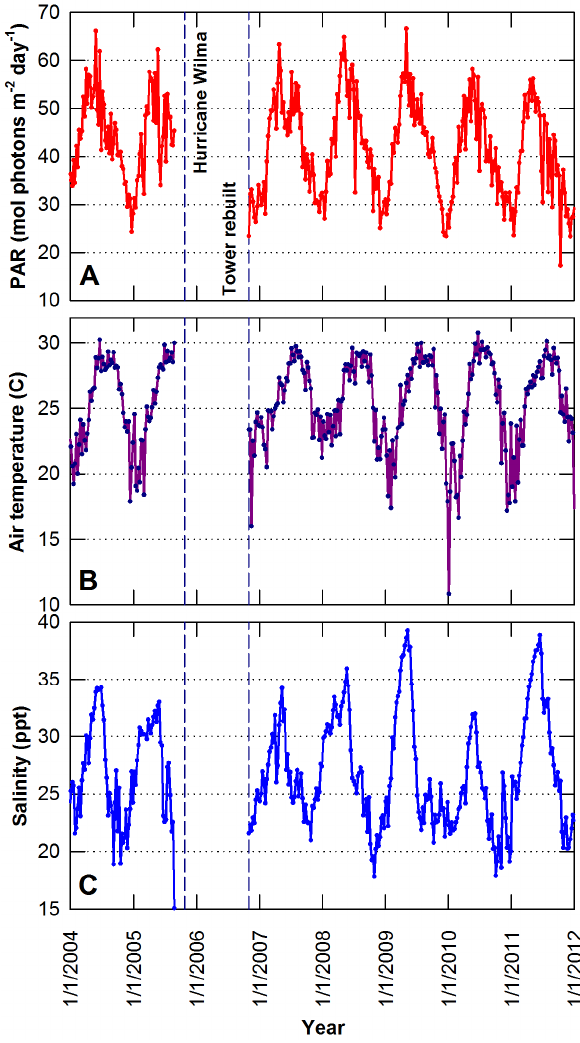
Fig. 5. Eight-day sums of –NEE, mol C m -2 day -1 ( A ) from the SRS6 tower site and derived products including ecosystem respiration, R E ; mol C m -2 day -1 ( B ), gross primary productivity, GPP; mol C m -2 day -1 ( C ), and light (PAR) use efficiency LUE; mmol C (mol photons) -1 ( D ).